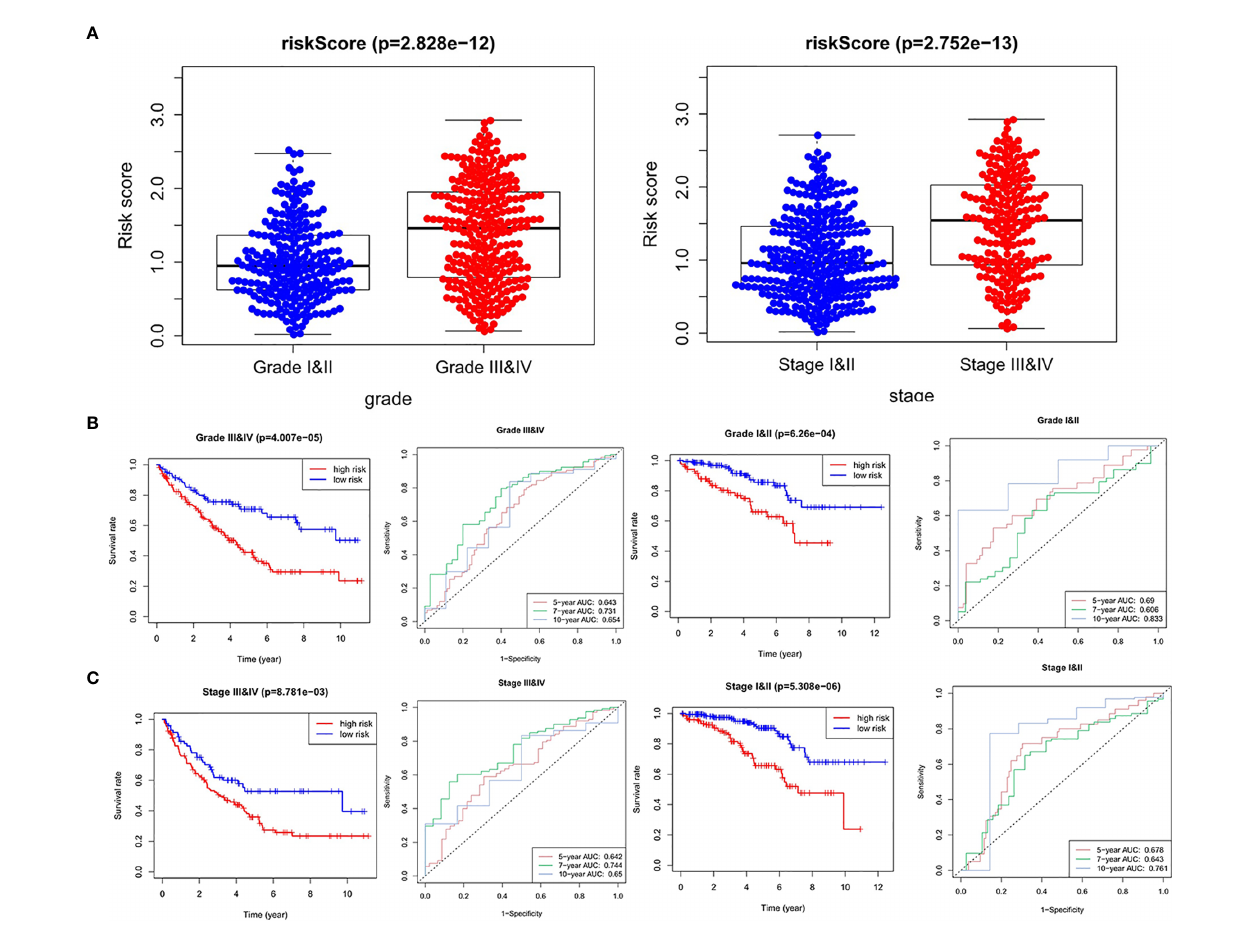
FIGURE 6 | Relationships between risk score and clinicopathological factors. (A) Risk score between high grade (grades III and IV) and low grade (grades I and II), advanced stage (stages III and IV), and early stage (stages I and II). Strati fi ed analysis between the high-risk group and low-risk group in the same grade (B) and stage (C)